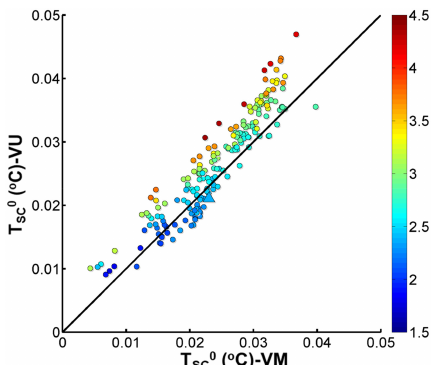
Figure 8. Comparison of T 0 calculated by the VM and VU mod- SC els. The triangle corresponds to the standard run. The colour scale of Z ∗ is the same as in Fig.